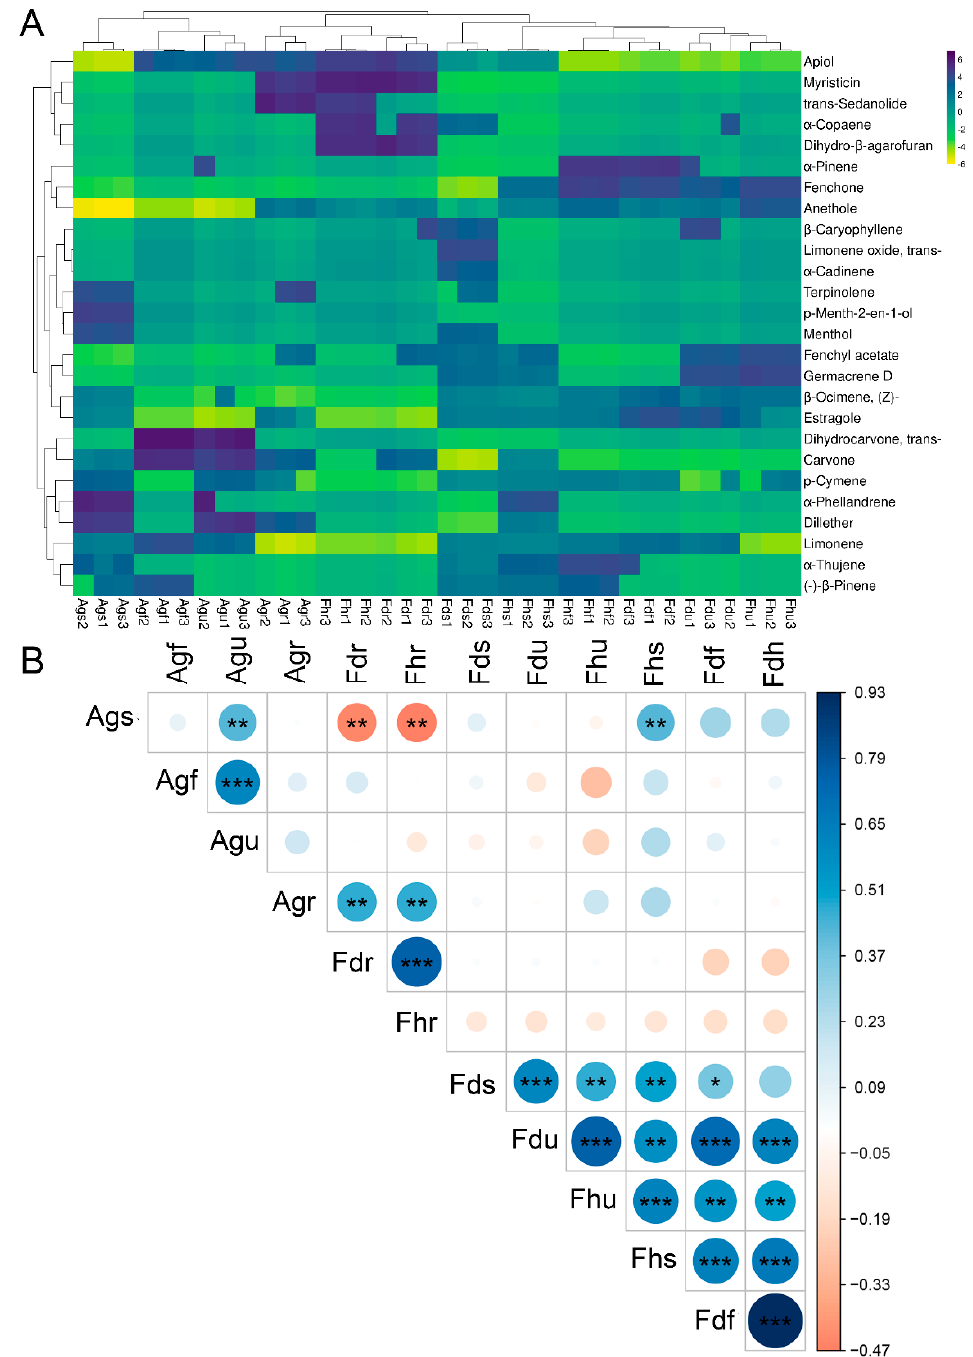
Figure 4. Heatmap ( A ) and Spearman rank correlation plot ( B ) based on EO chemical profiling. (* p < 0.05, ** p < 0.01, *** p < 0.001).